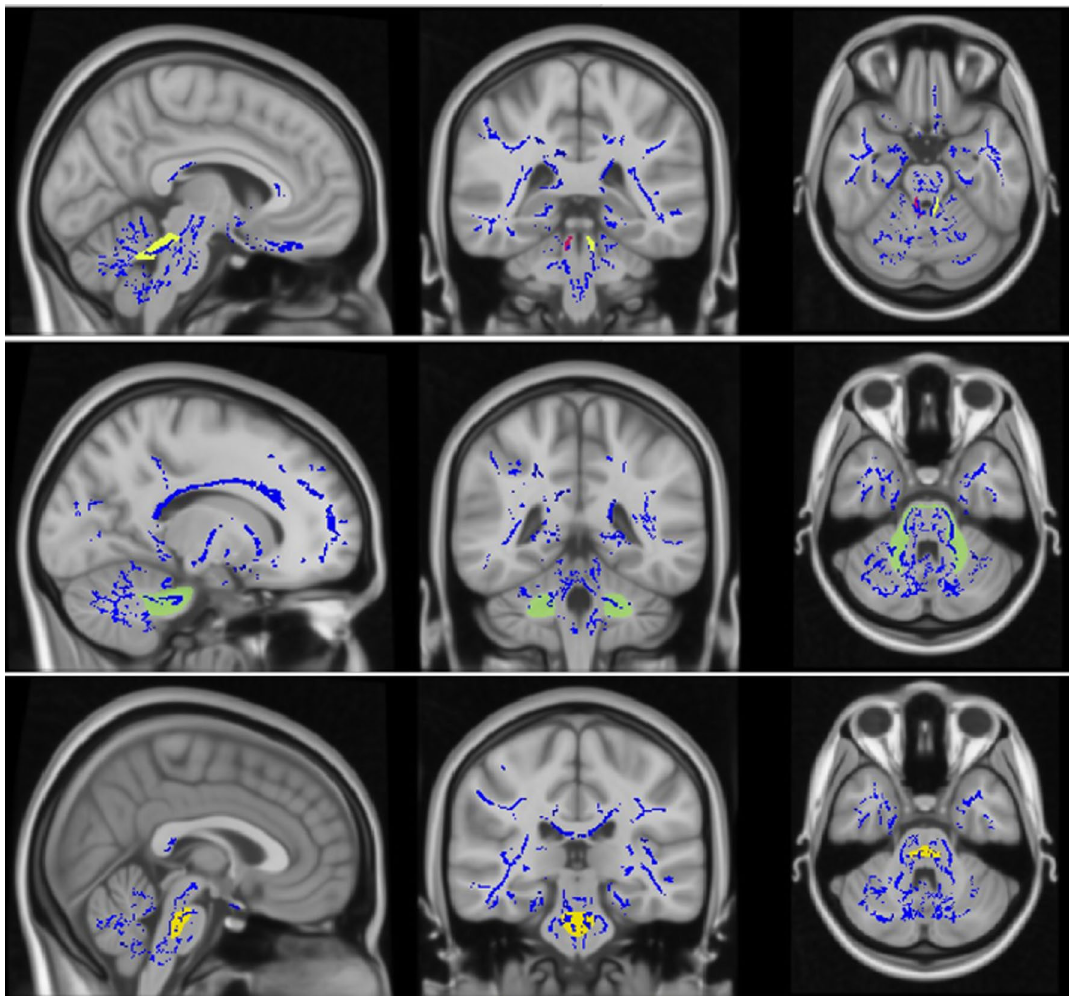
Fig. 11 Brain stem tracts; superior cerebellar peduncles, middle cerebellar peduncles and pontine crossing tracts from top to bottom row, respectively, showing statistically significant ( p value < 0.001) higher mean FA value in ASD group compared to TDC group displayed in